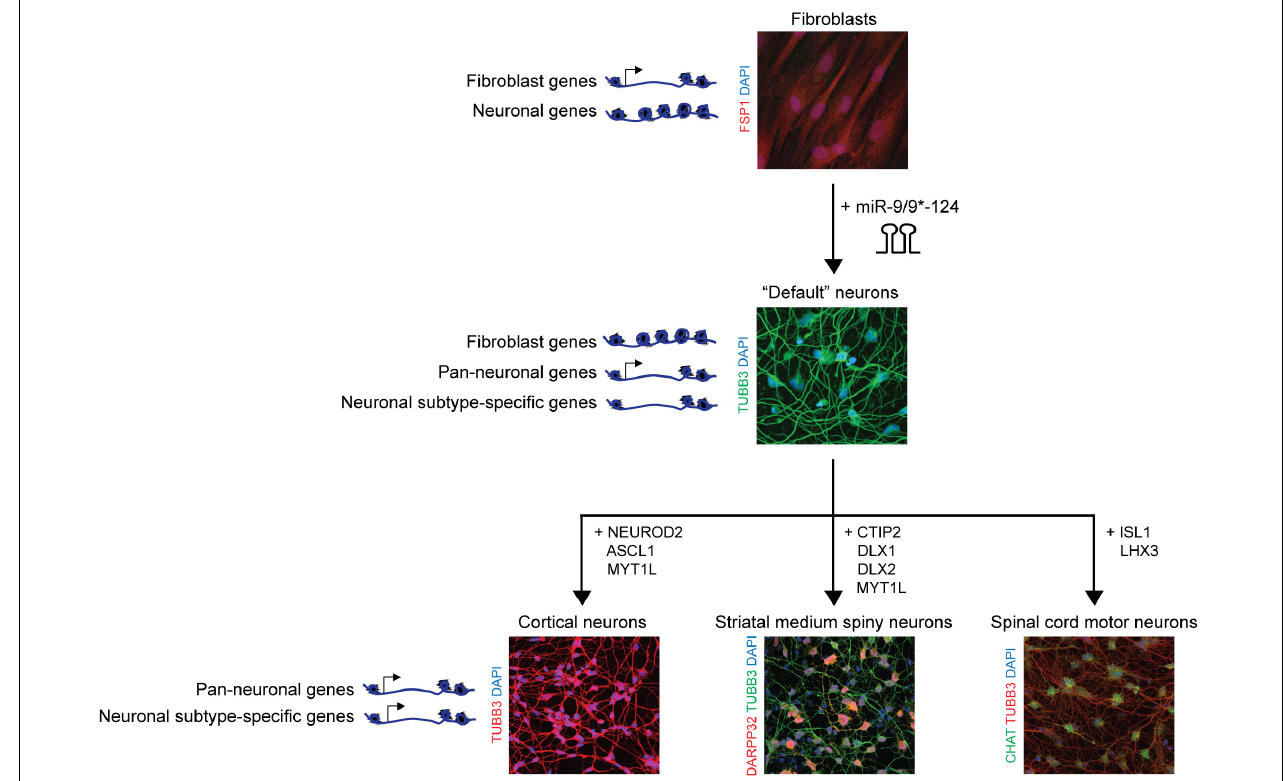
FIGURE 2 | Synergism between microRNAs and transcription factors for subtype-specific neuronal reprogramming of human adult fibroblasts. MiR-9/9 ∗ -124 mediate the erasure of fibroblast fate through remodeling of a fibroblast-specific chromatin landscape and transcriptome profile and promote a neuronal chromatin landscape and transcriptome. MiRNA alone generates a default neuronal state characterized by the reconfiguration of the chromatin state permissive to the subtype-defining inputs of transcription factors. With distinct combinations of transcription factors, the miRNA-based conversion have been successfully employed to generate cortical neurons (Yoo et al., 2011), striatal medium spiny neurons (Victor et al., 2014), and spinal cord motor neurons (Abernathy et al., 2017).